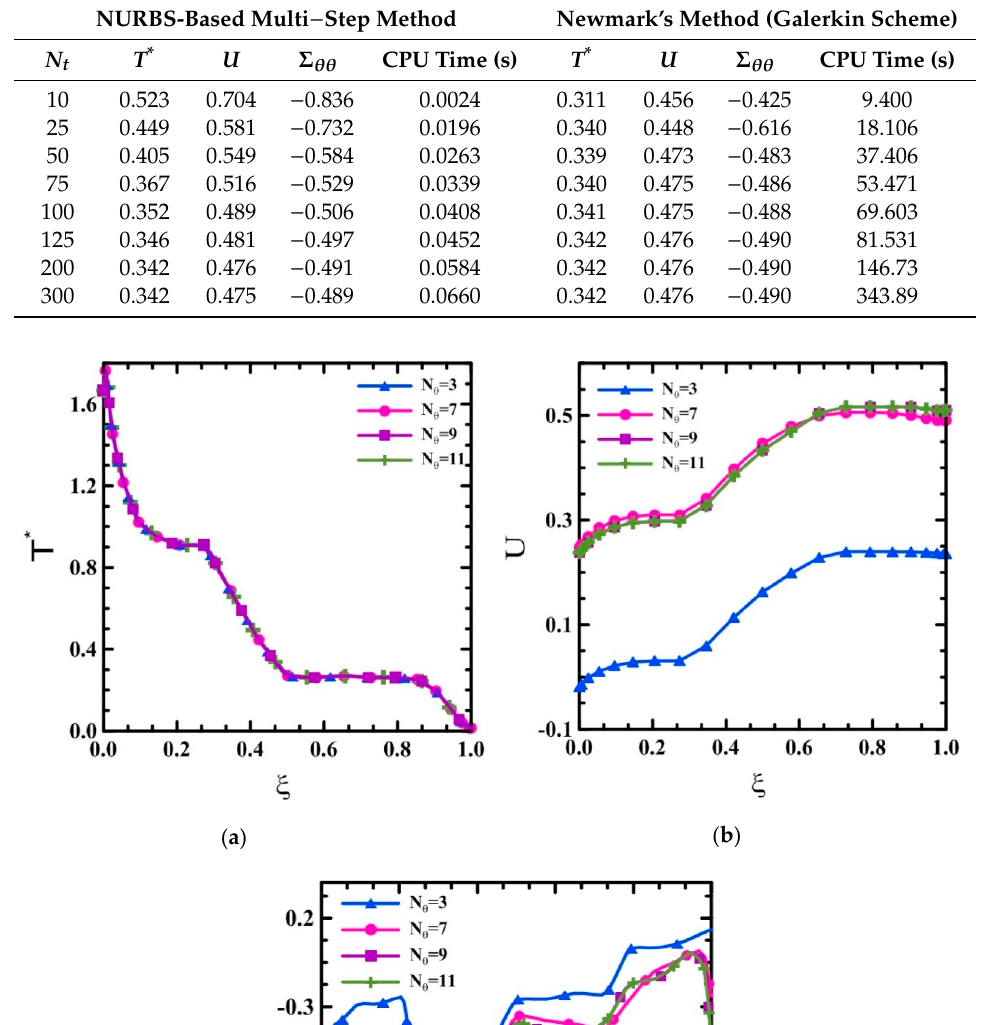
Table 3. Comparison between a NURBS-based multi-step technique and the Newmark’s scheme (cid:16)